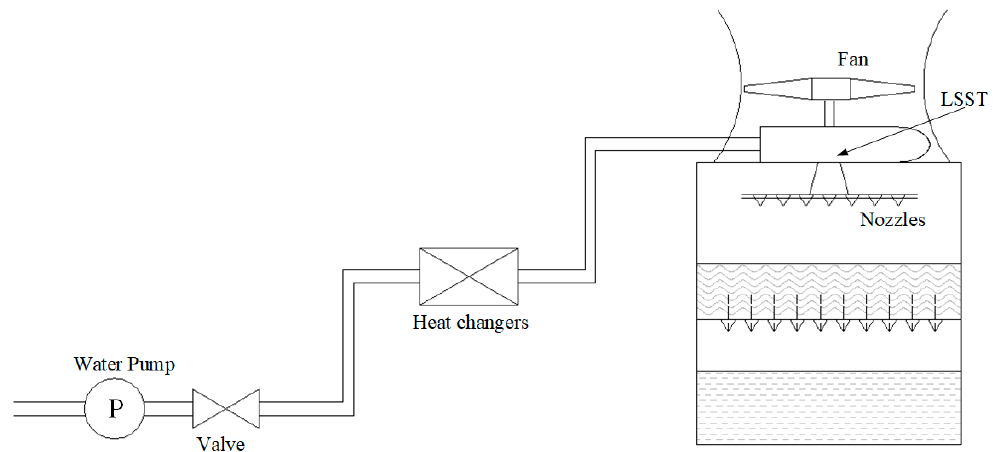
Figure 1. A sketch of Low Specific Speed Turbine (LSST)-Fan unit installed in the circulating water system of the cooling tower.